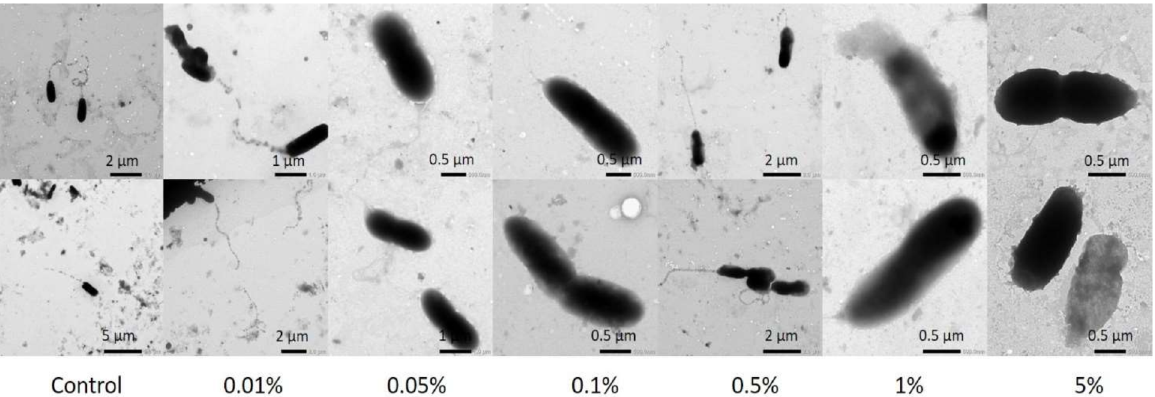
Figure 12. PHMG-Cl effects cell shape, causing damage to the cell wall and membrane. Shown here are TEM images of PA cells subjected to different PHMG-Cl